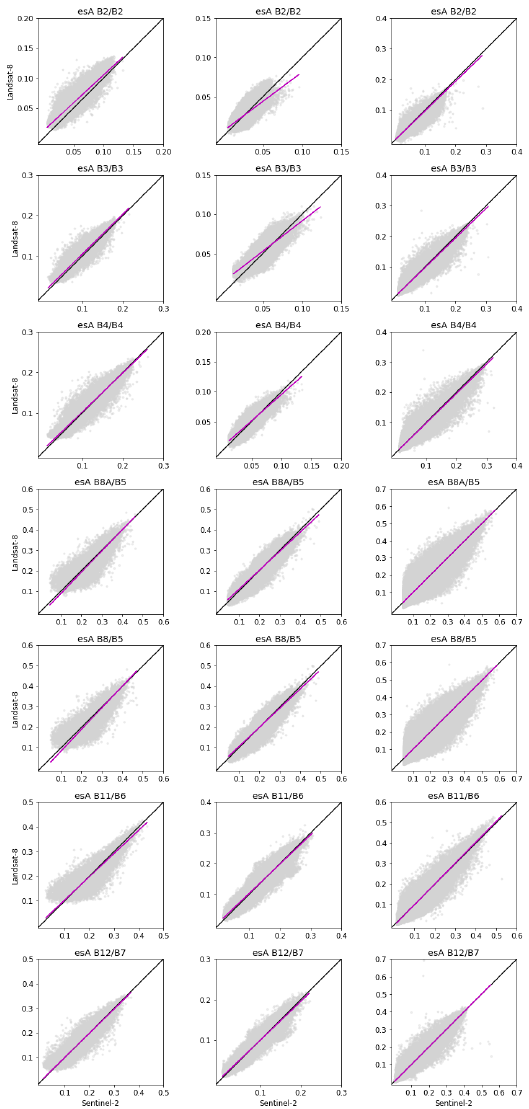
Figure A5. Comparison of Eastern Siberian Adjusted (esA) the Sentinel-2 reflectance values and Landsat-8 corresponding bands for the individual study sites. In the order from left to right: Lena Delta, Batagay, and Yakutsk. The solid black line is one-to-one, and the pink line is the ordinary least squares regression trend